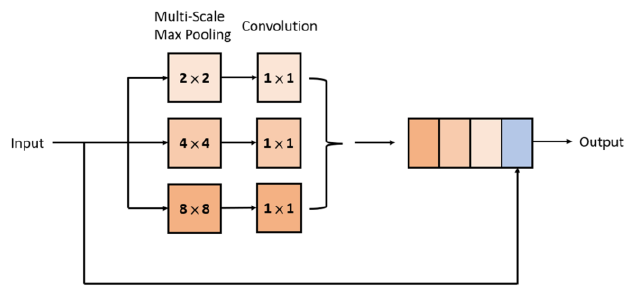
Figure 3. An illustration of an SPP block.